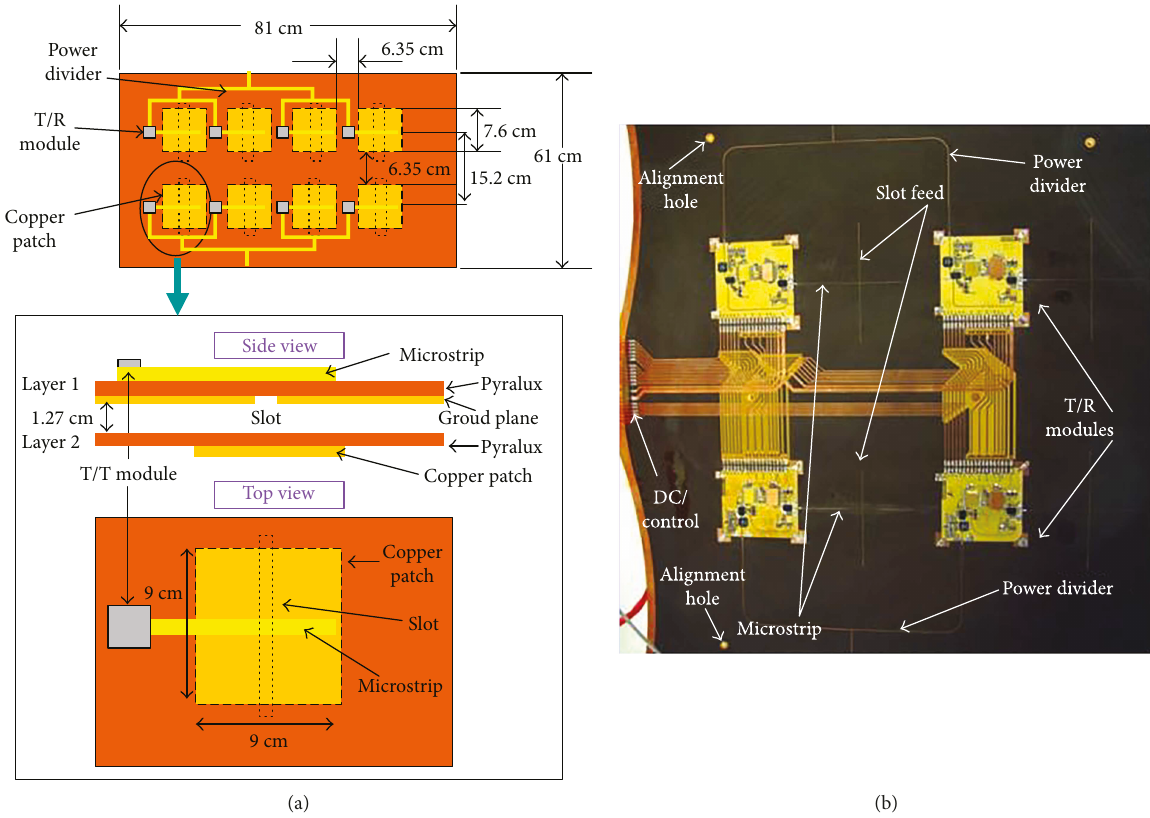
Figure 16: Membrane antenna architecture. (a) 2 × 4 element array. Unit cell top and side views. (b) A close-up of the membrane array showing four of the T/R modules of the array [73].